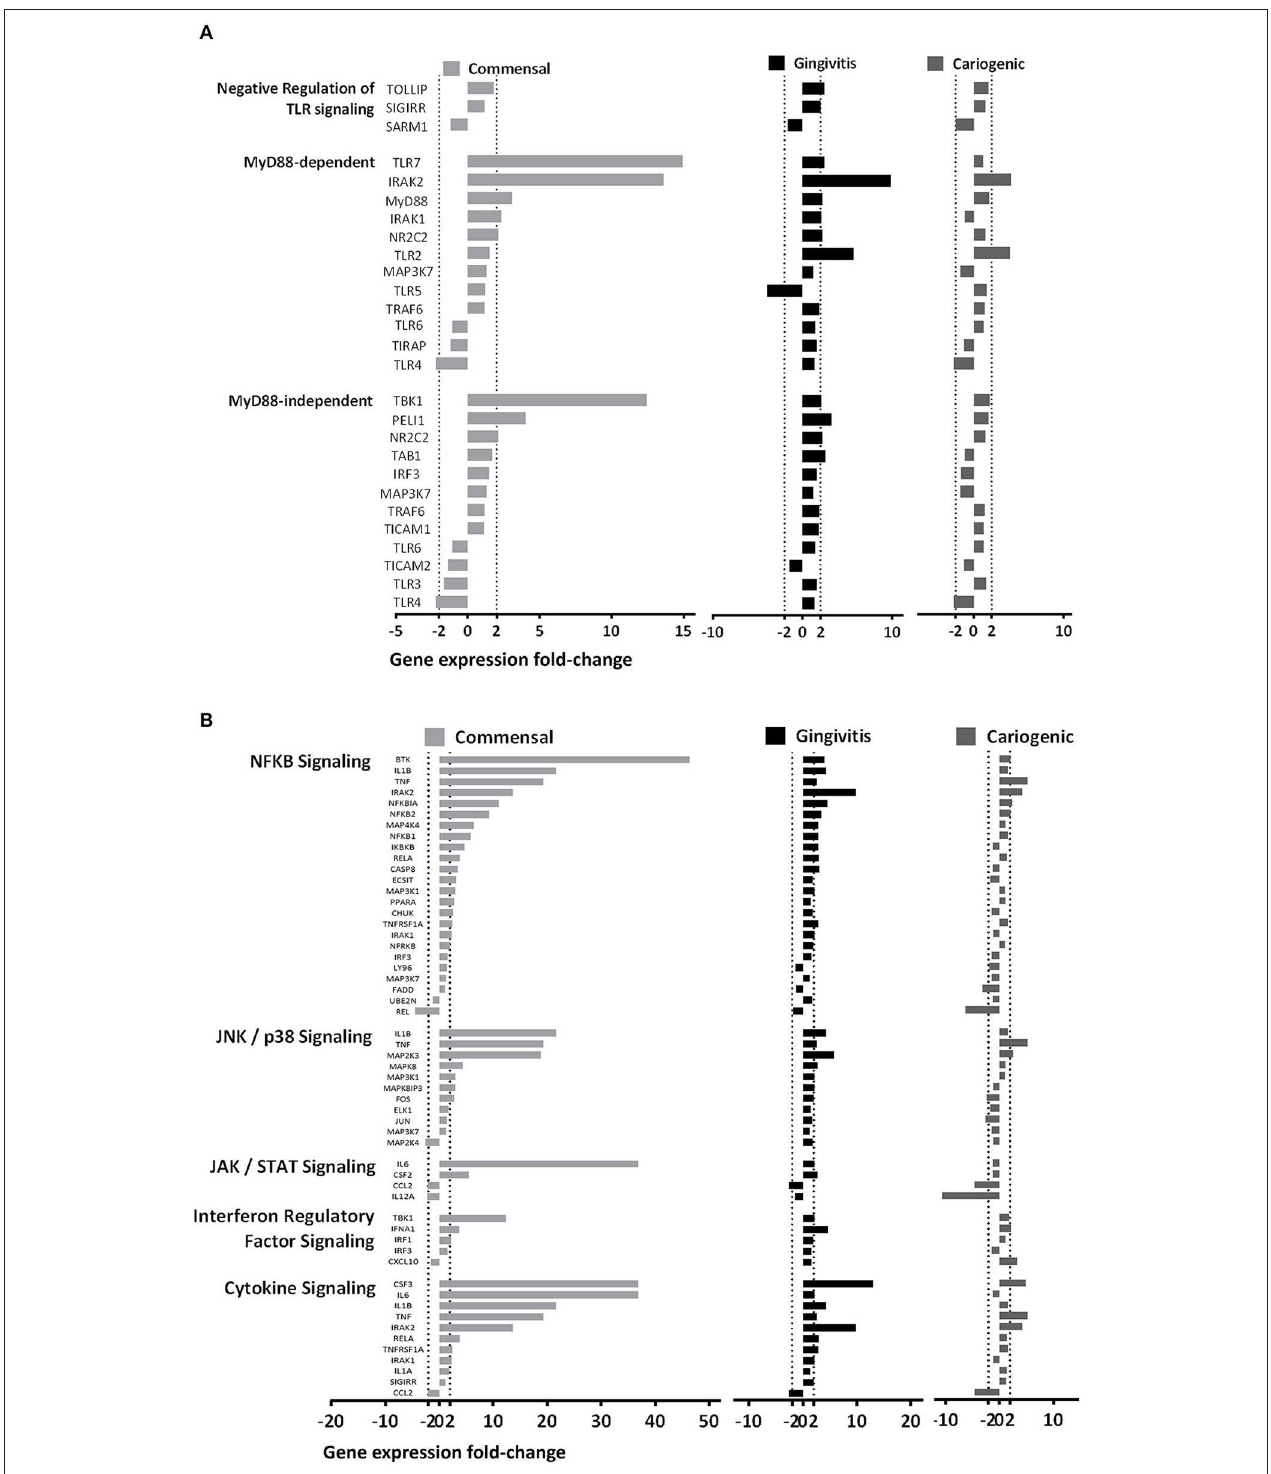
FIGURE 5 | Biofilms differentially regulate MyD88 dependent and independent pathways. (A) Genes related to the two main TLR downstream cascades (MyD88-dependent and Myd88-independent pathways) are shown. The commensal biofilm up-regulated both pathways more than the gingivitis or the cariogenic biofilms. (B) Other downstream pathways related to TLR signaling are shown. The commensal biofilm showed strong up-regulation on all five pathways in comparison to the two pathogenic biofilms. Data represent three independent experiments, each with an intra-experiment duplicate.